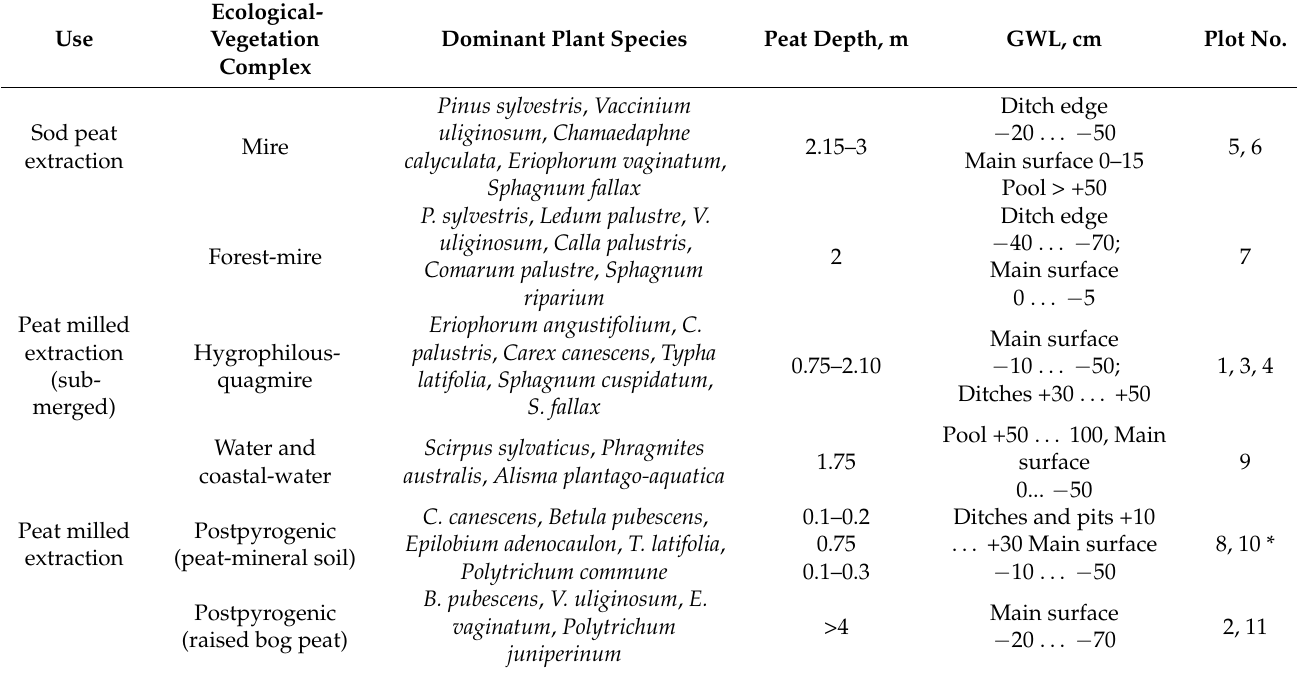
Table 2. Previous economic use; type of ecological-vegetation complex and its characteristics at the beginning of monitoring; numbers of permanent plot.